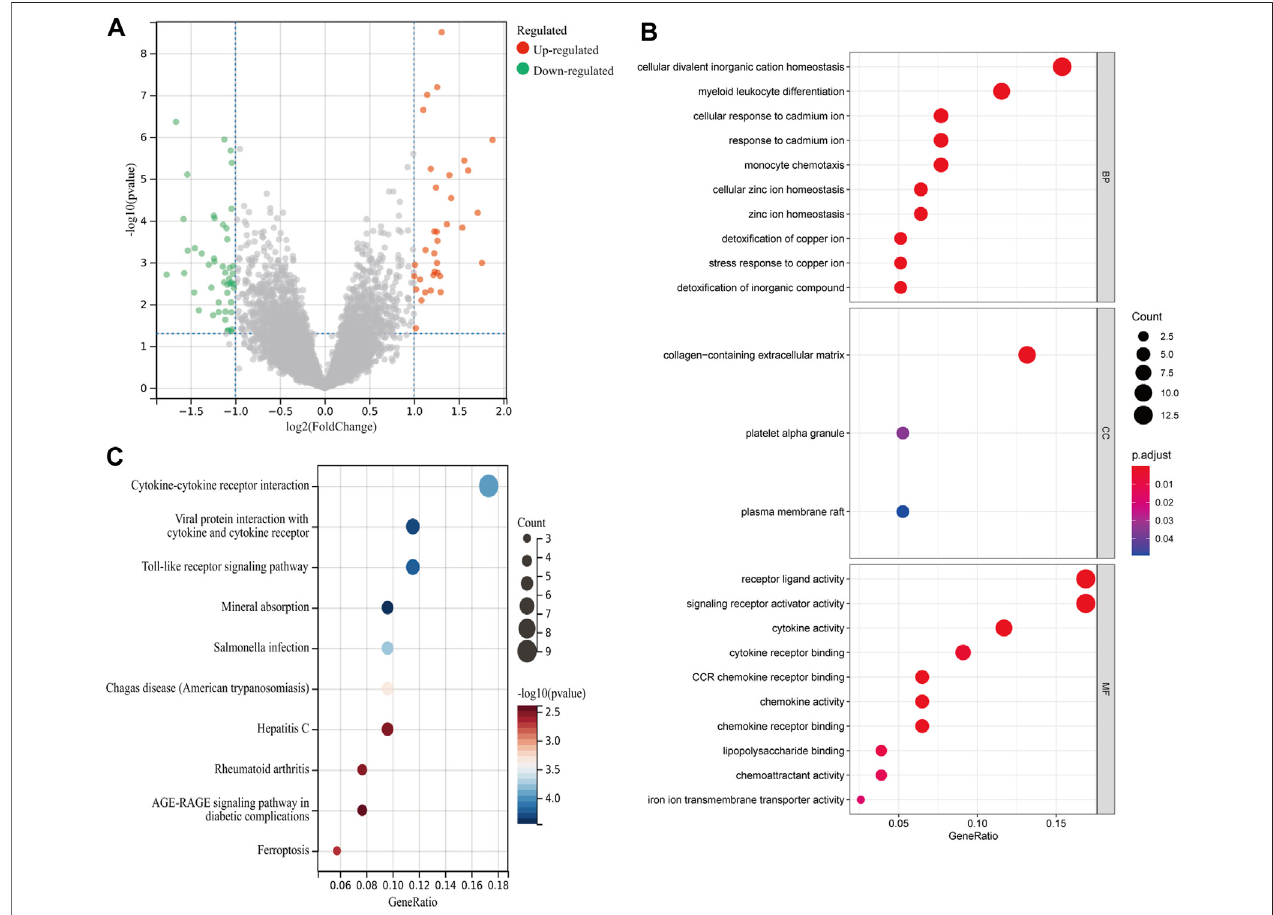
FIGURE 1 | Differential analysis between rAAA and eAAA. (A) The scatter plot shows the DEGs between the rAAA and eAAA groups. Red represents relatively upregulated genes,and greenrepresentsdownregulatedgenes. (B) Bubble plot ofGOenrichmentanalysisofDEGs.The sizeofthedots corresponds tothenumber of genes, and the color of the dots represents the p value . (C) Bubble plots of the top 10 KEGG pathways for molecular function.